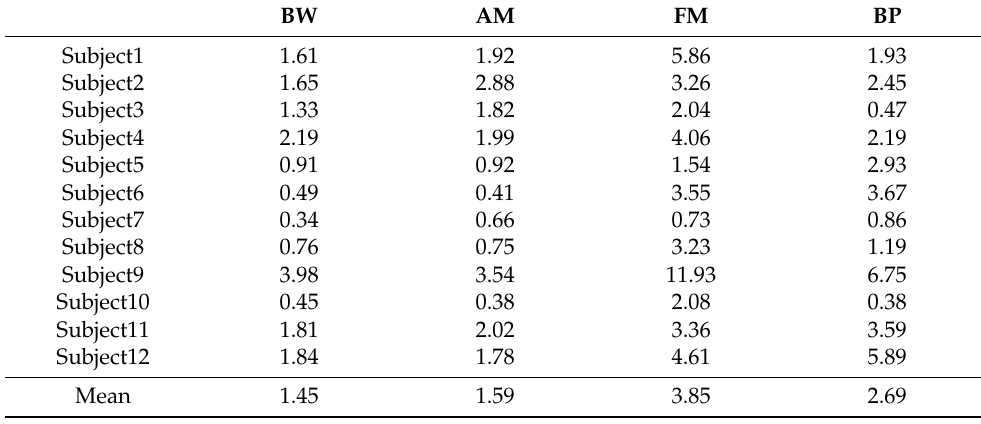
Table 2. The EDR MAE of each subject on different EDR methods, averaged across auscultation sites.